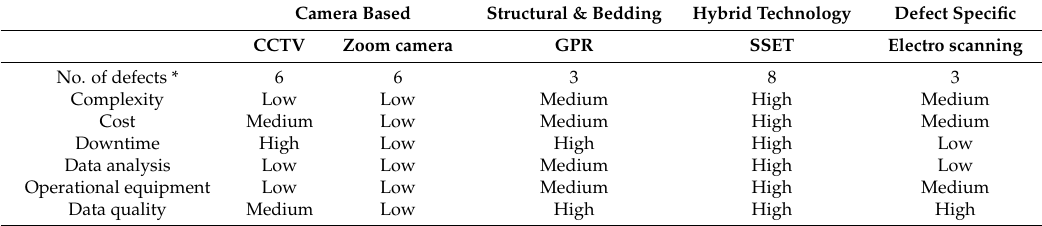
Table 2. Sewer inspection technologies